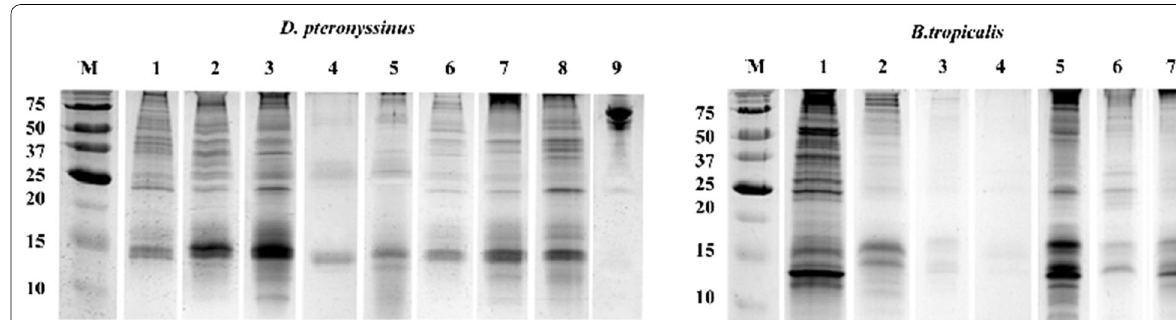
Fig. 1 SDS PAGE of commercial extracts ( D. pteronyssinus ) from manufacturers 1 to 9